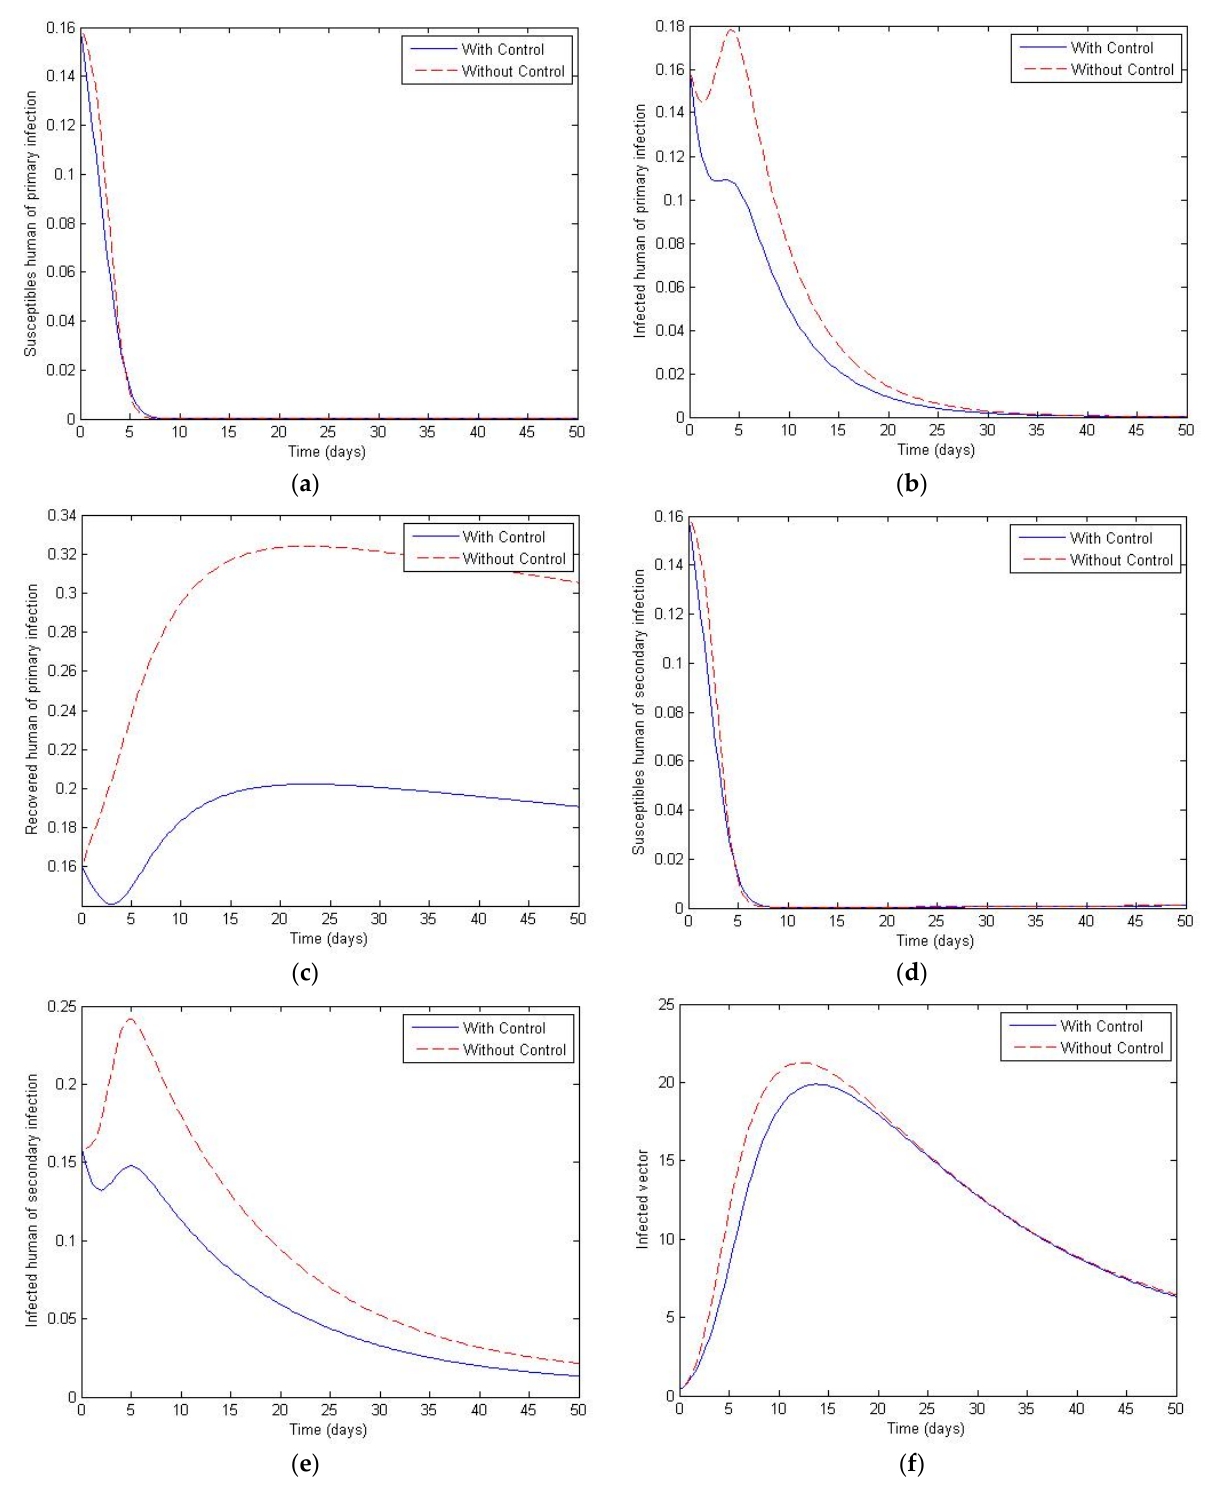
Figure 15. Simulation results of system of Equations (38)–(43) with and without controls of S HP , I HP , R HP , S HS , I HS and I V when X 1 = 100, X 2 = 0.00001. ( a ) Susceptibles of primary infection ( b ) Infected population with primary infection ( c ) Recovered human of primary infection ( d ) Susceptibles of secondary infection ( e ) Infected human of secondary infection (f) Infected